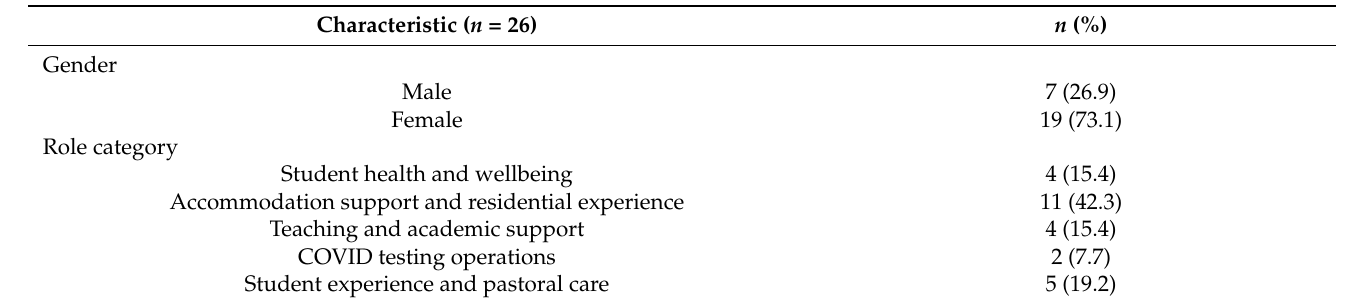
Table 2. Sample characteristics of